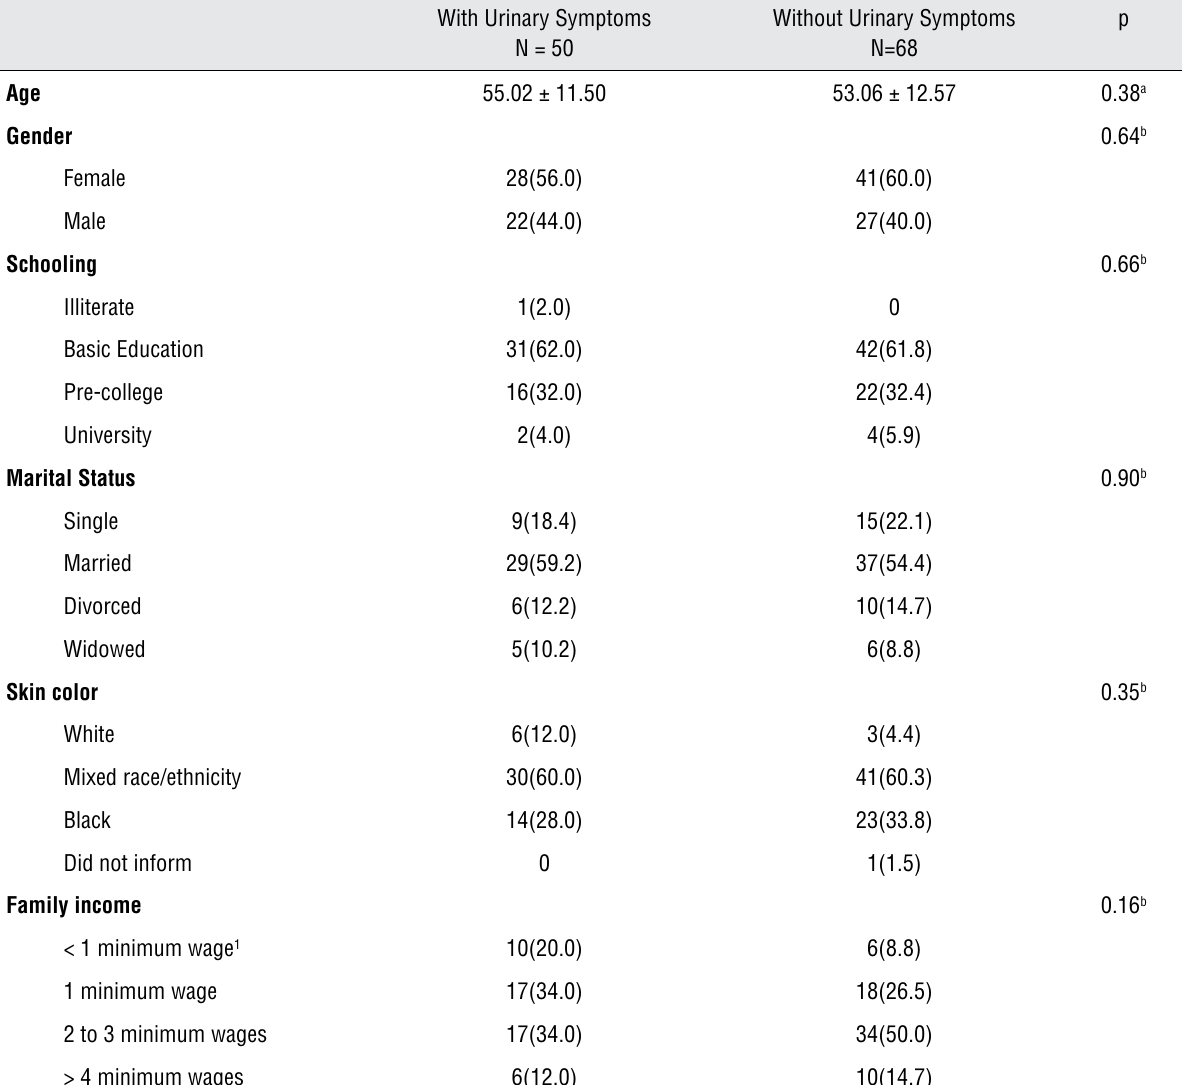
Table 1 - Sociodemographic characteristics of the HTLV-1 infected subjects with HTLV-1 with and without urinary symptoms.